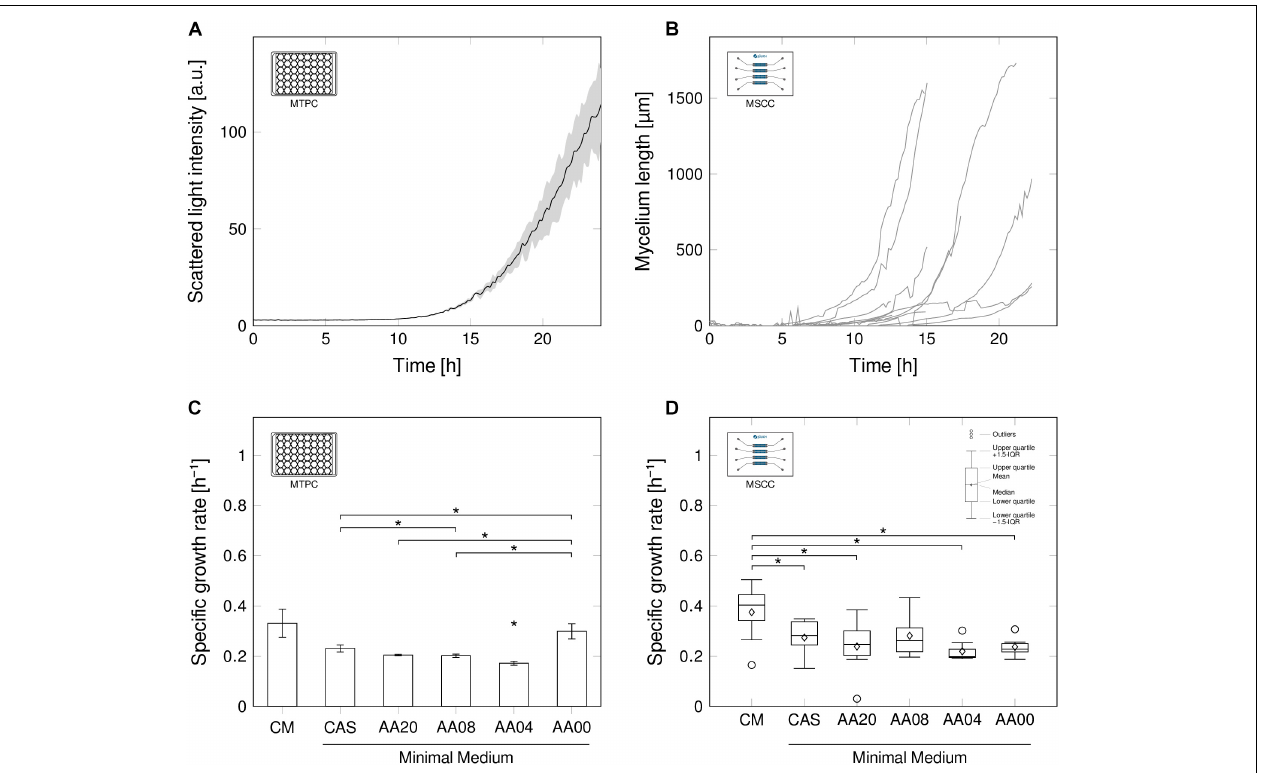
FIGURE 2 | Growth behavior of Streptomyces lividans in MTPC (A,C) and MSCC (B,D) . (A) Scattered light intensity obtained from MTP cultivation (MTPC), exemplarily for CM ( n = 3), using a spore suspension for inoculation. (B) : Total mycelium length [ µ m] over process time for n = 8 representative spores in microfluidic MSCC all grown in CM; image analysis was stopped when complexity of mycelium impaired evaluation. (C,D) , Specific growth rates for six media compositions (each n = 3) with decreasing level of complexity ( Table 1 ) in the MTPC and MSCC. Significant differences ( p < 0.05) are indicated by an asterisk ( ∗